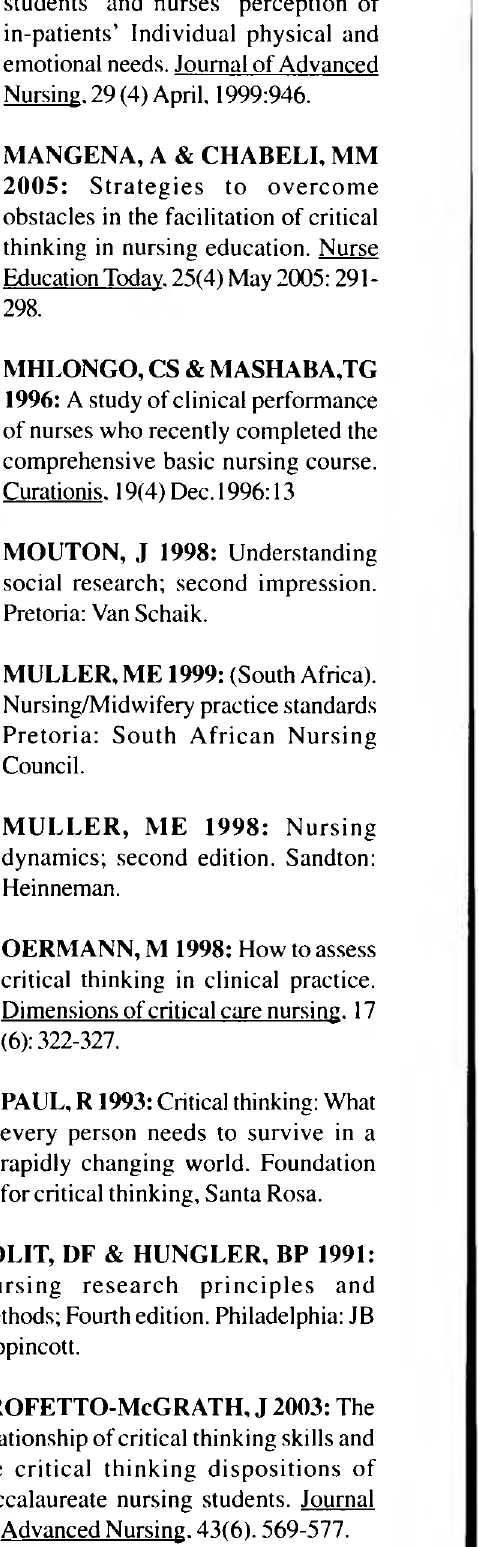
Figure 1.3 The box-and-whisker plots of knowledge of assessment, diagnosis, planning, implementation, evaluation and recording